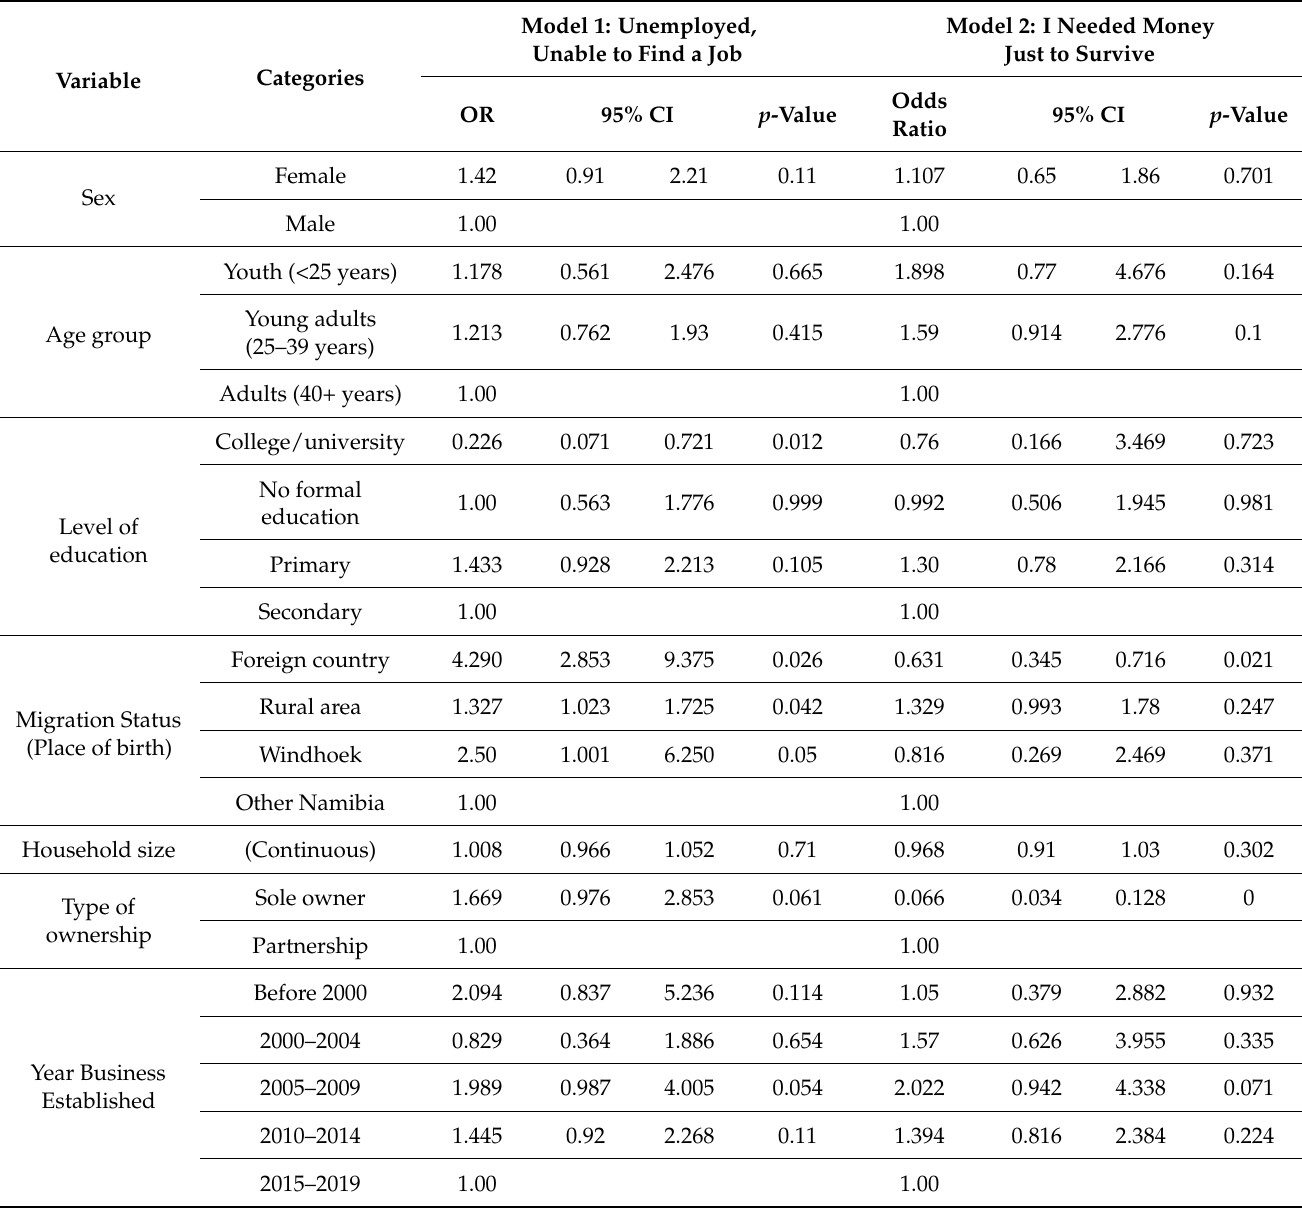
Table 12. Characteristics of